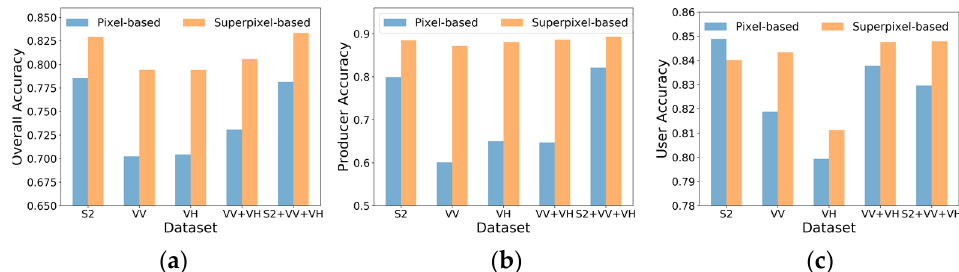
Figure 9. Classification accuracies of pixel-based classification and superpixel-based classification: ( a ) Overall accuracy; ( b ) Producer accuracy; ( c ) User accuracy.